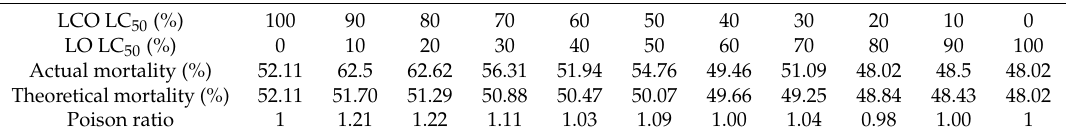
Table 4. Toxicity of mixtures with different LC 50 ratio of Ligusticum chuanxiong oil (LCO) and lemongrass oil (LO) against Aphis citricola van der Goot (24 h).